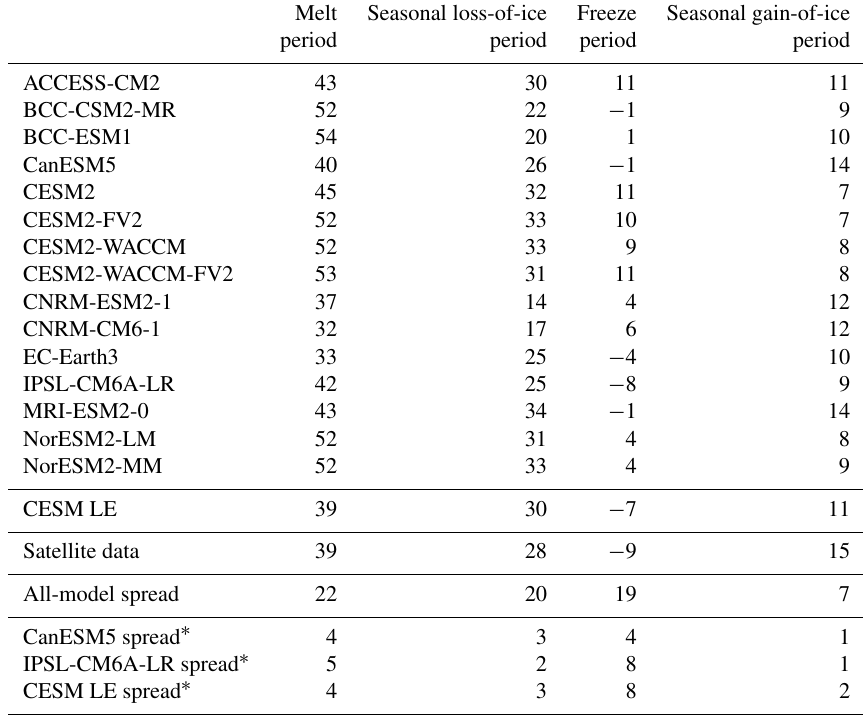
Table 4. Lengths of pan-Arctic, satellite-era (1979–2014) means of intraseasonal transition periods in days. The satellite-era means and the all-model spreads (latest minus earliest) are calculated using the first ensemble member from each model. Negative values indicate where the freeze-up date falls earlier than the freeze onset on average. Models labeled with ∗ show the spread in means between the first 30 ensemble members of that model. Model spreads are given in days, and all metrics are calculated between 66 and 84.5 ◦ N.